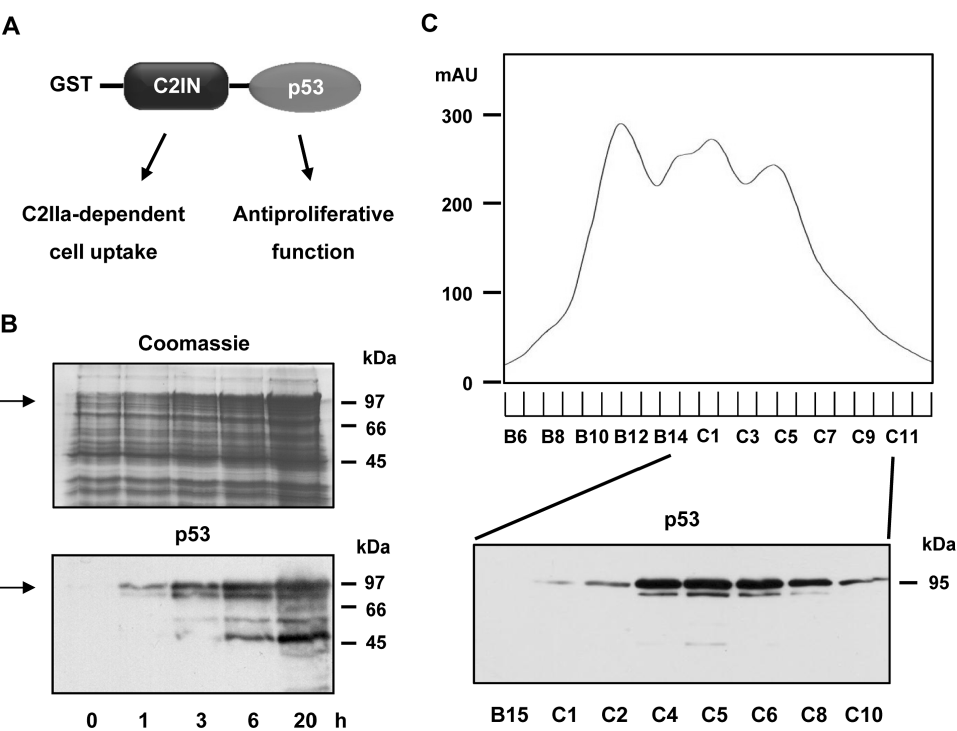
Figure 1. Expression and purification of recombinant GST-C2IN-p53. A . Scheme of GST-C2IN-p53 fusion construct. B . Time course of GST- C2IN-p53 expression in E. coli Rosetta. Samples were harvested after time points indicated (0, 1, 3, 6 and 20 h) and subjected to SDS-PAGE followed by Coomassie staining (top) or Western blot analysis using a p53 antibody (bottom). GST-C2IN-p53 is denoted by an arrow. C . Purification of GST- C2IN-p53 fusion protein by heparin affinity chromatography. GST-C2IN-p53 was isolated from whole cell extracts by heparin-based chromatography and eluted by a linear salt gradient as monitored by UV absorbance. Subsequently, fractions collected during affinity chromatography were characterized by immunoblot analysis with p53 antibody.